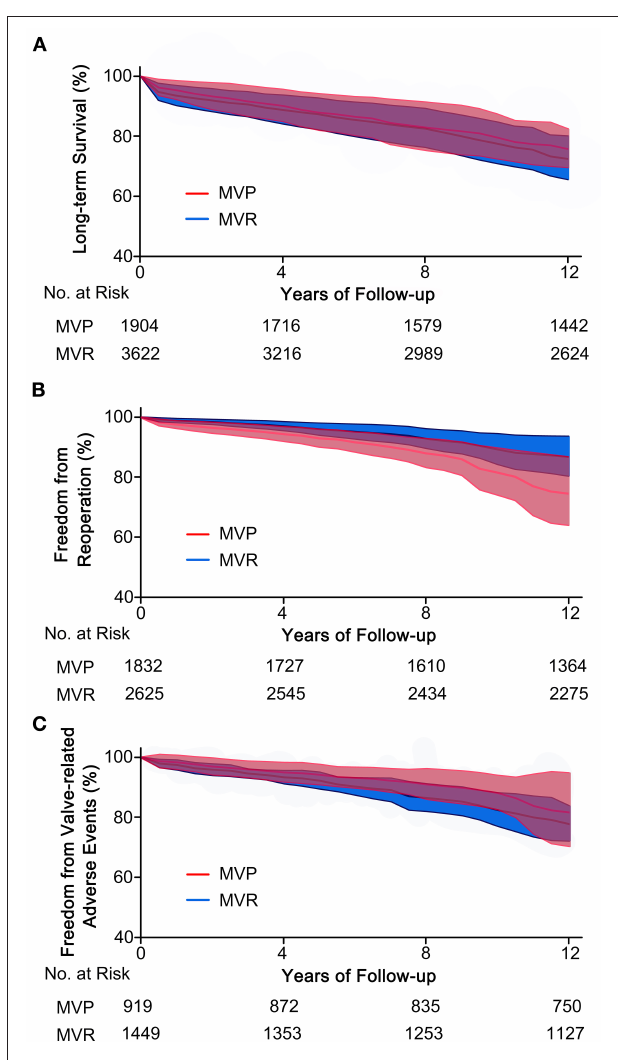
FIGURE 4 | Reconstructed Kaplan-Meier curves for MVP and MVR in patients with RHD. (A) Reconstructed curves of long-term survival from 10 studies, (B) reconstructed curves of freedom from reoperation from 10 studies, and (C) reconstructed curves of freedom from valve-related adverse events from four studies. MVP, mitral valve repair; MVR, mitral valve replacement; RHD, rheumatic heart disease.